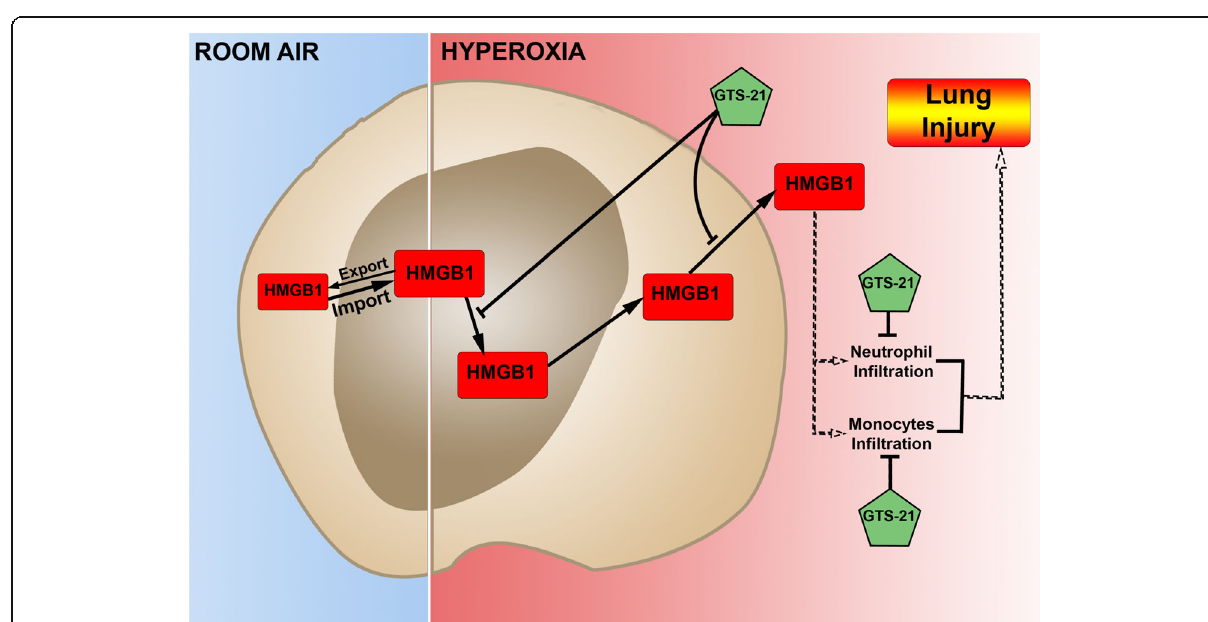
Fig. 5 Suggested pathways of GTS-21-mediated attenuation of HALI. In cells, including lung cells, HMGB1 shuttles between the nucleus and cytoplasm. Under room air, the rate of HMGB1 nuclear import exceeds that of re-diffusion plus export. Thus, HMGB1 appears predominantly or solely in the nucleus. The prolonged exposure to hyperoxia induces HMGB1 translocation from the nucleus to the cytoplasm. The α 7nAChR agonist, GTS-21, inhibits hyperoxia-induced translocation and subsequent release of nuclear HMGB1, and its accumulation in the airways and the circulation. As a result, GTS-21 is efficacious in attenuating hyperoxia-induced infiltration of leukocytes, including neutrophils and inflammatory monocytes, into the airways, thereby significantly reducing hyperoxia-induced inflammatory lung